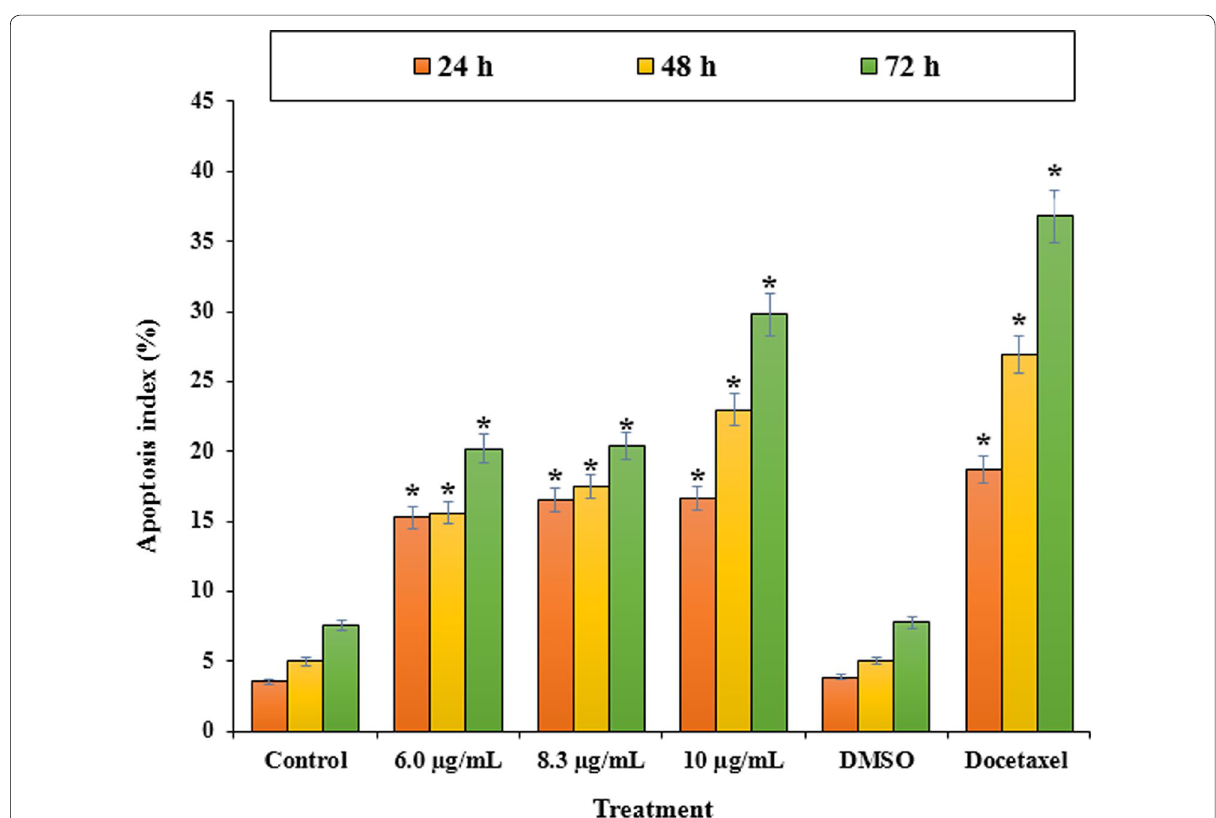
Fig. 6 PI-staining induced apoptosis on LNCaP cells. LNCaP cells were treated with different concentrations of L. usitatissimum extract for 24, 48, and 72 h. *Indicate the significant difference ( p < 0.01) between experimental groups with control/DMSO